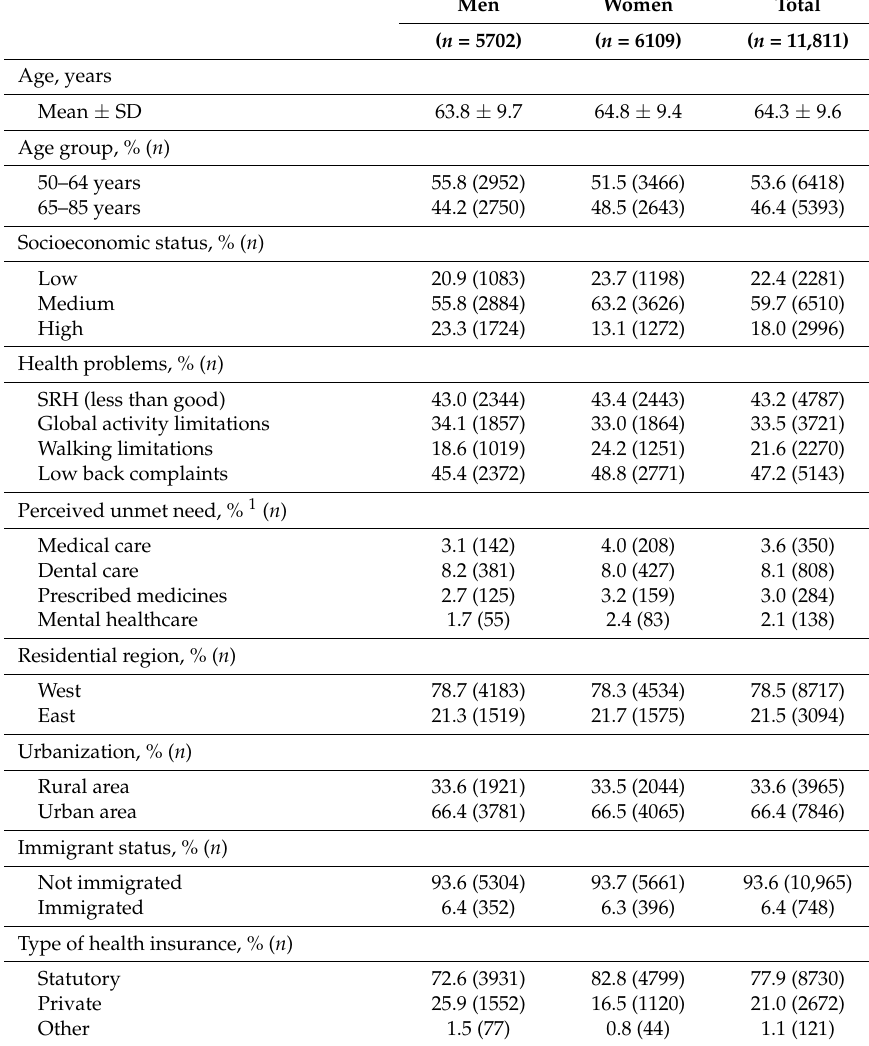
Table 1. Characteristics of the study